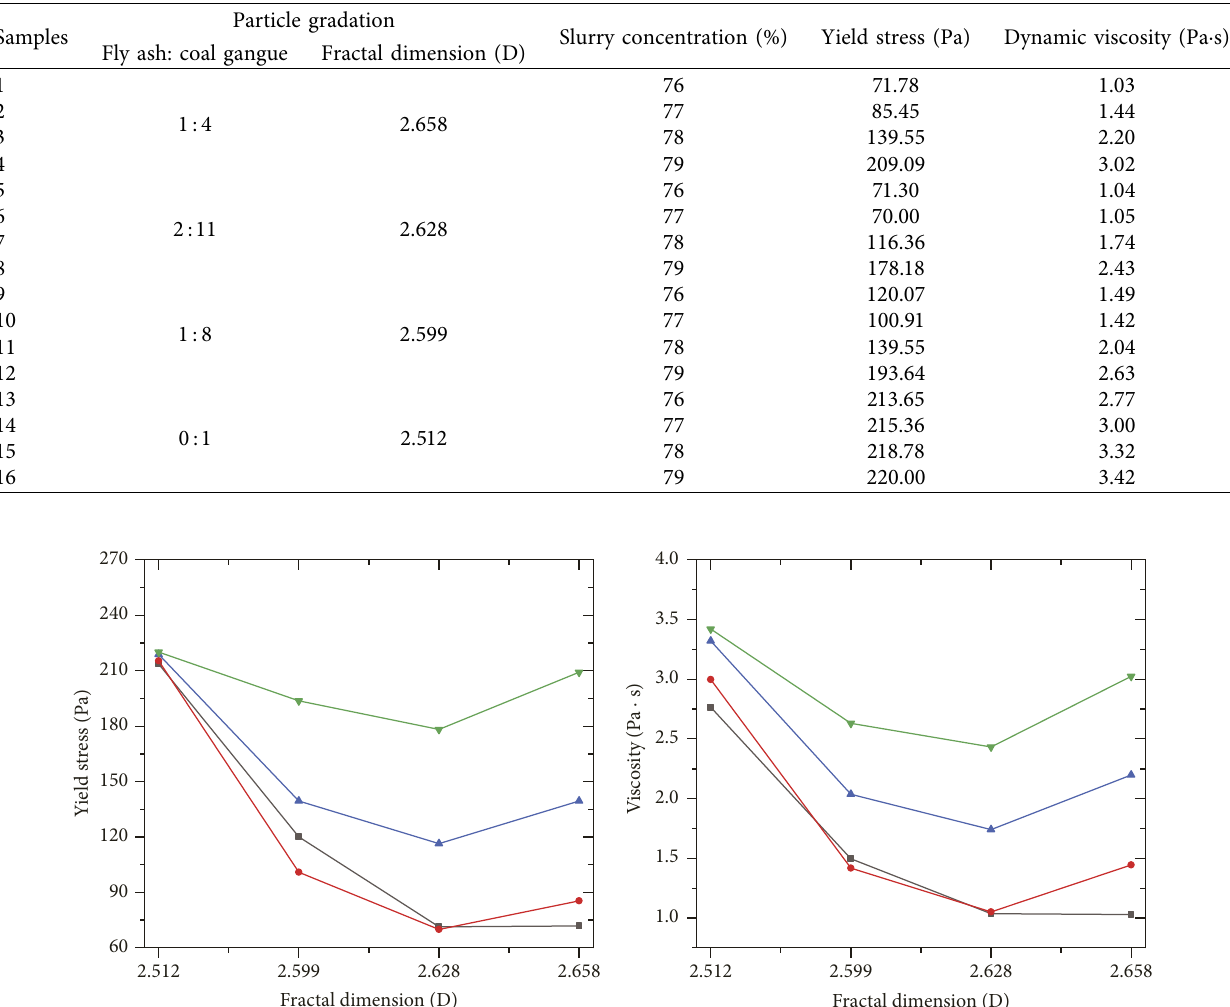
Table 5: Rheological parameters of slurry at different proportions.